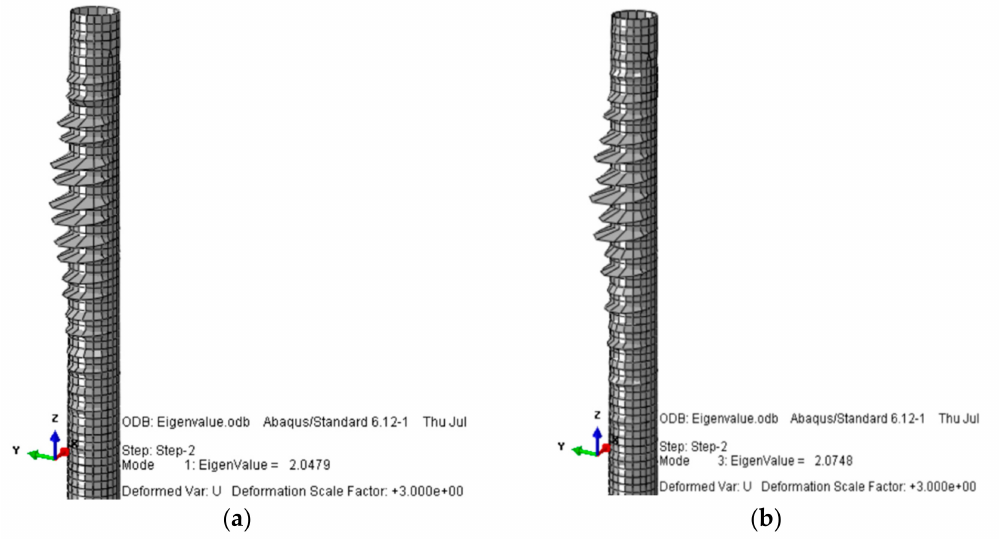
Figure 6. Tower_T_B Eigenmodes: ( a ) 1st Eigenmode; ( b ) 2nd